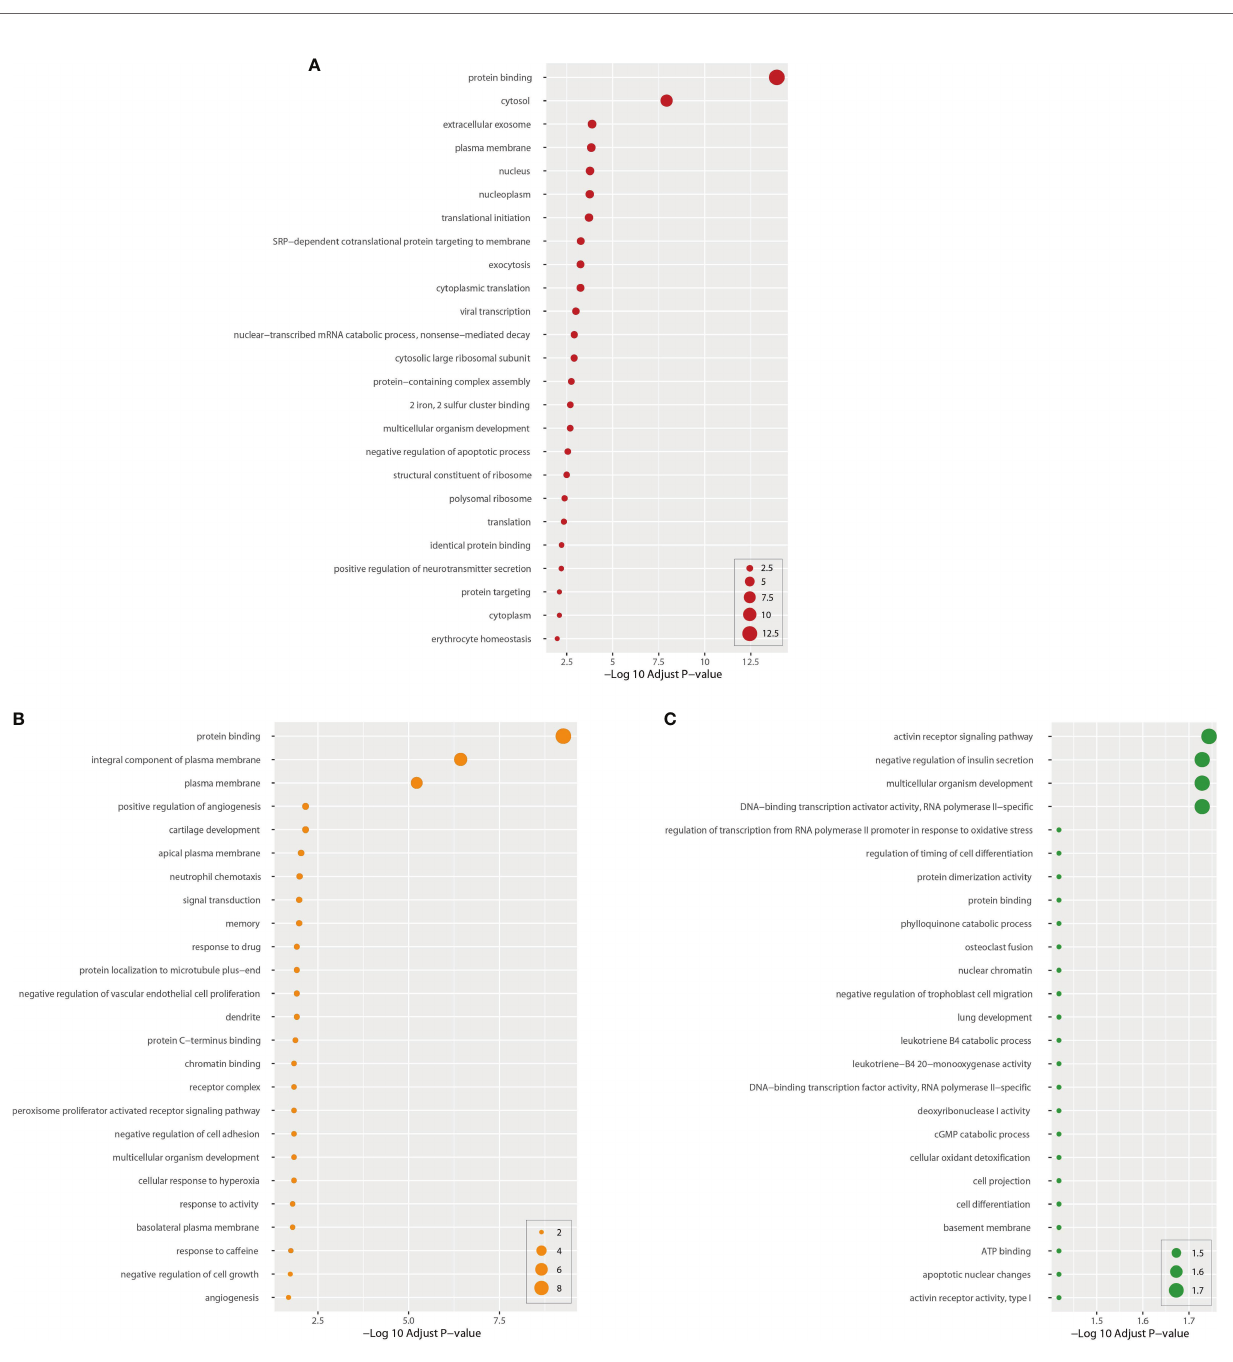
FIGURE 4 | Top 25 gene ontology between COVID-19 and mental disorders. The ontology cascades were determined using the DEGs for each of the condition and the combined genes of COVID-19 whole blood and immune samples. Panel (A) exhibits the ontology for BD. Panels (B, C) exhibit ontology cascades for SZ and LOD,